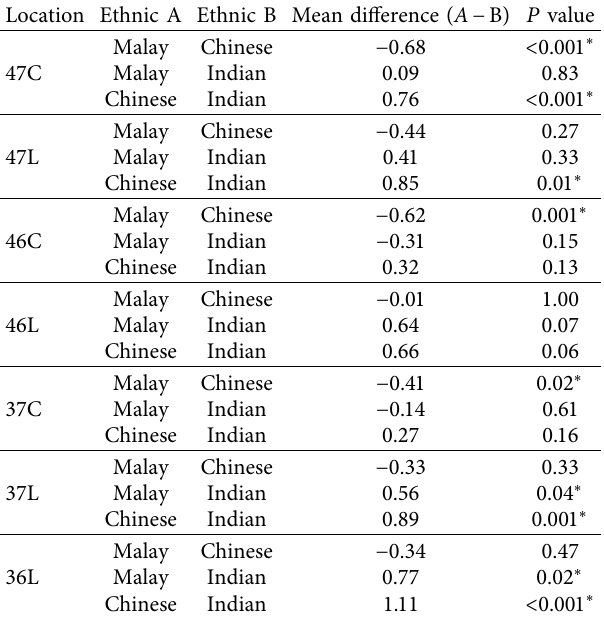
Table 4: The post hoc test results showing the mean differences in statistically significant measurements among the three ethnic groups (Malay, Malaysian Chinese, Malaysian